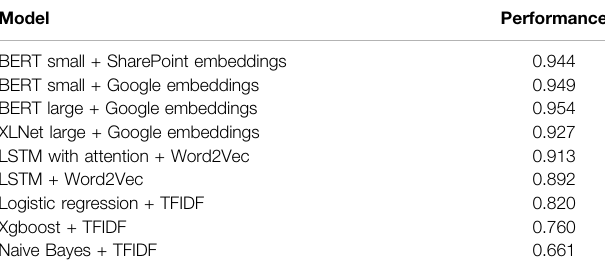
TABLE 2 | Comparison of intent classi fi cation performance. BERT and XLNet models were all trained for 30 epochs using batch size 16.